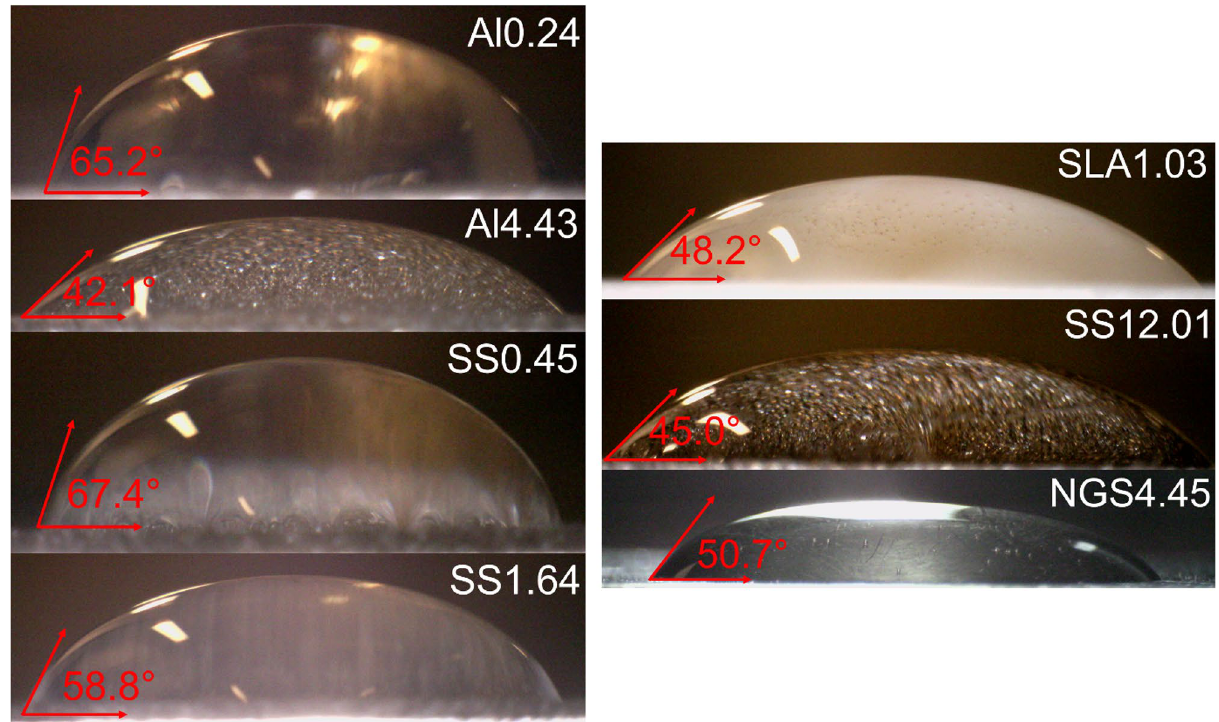
Figure 10. The contact angle measurement using the sessile drop method. Images show the static contact angle formed for water on aluminum, stainless-steel, 3D-printed polymer, 3D-printed stainless-steel, and natural graphite sheet surfaces. Table 1 lists the sample